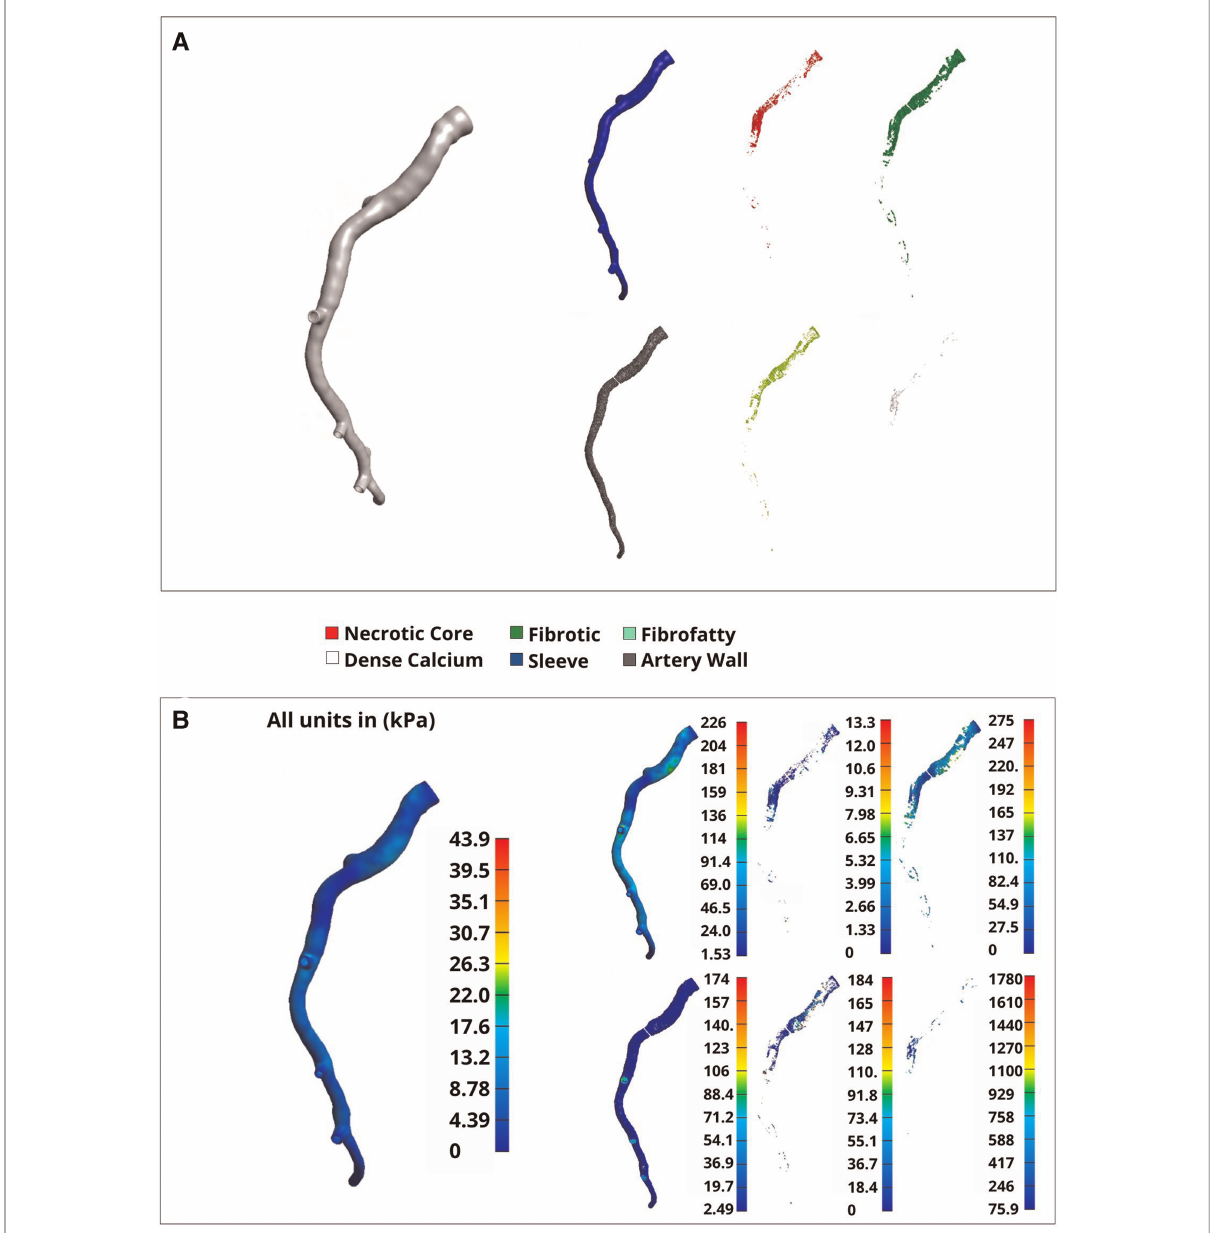
FIGURE 8 Volumetric elements and Von mises stress by material type. A full representative artery was reconstructed at a 0.2 mm resolution with tet4 elements. ( A ) Separated materials that were assigned using the plaque constituent pixel coordinates extracted from VH-IVUS images in “ VH-IVUS image processing and centerline orientation ” . ( B ) Nodal-smoothened effective stress across the entire artery (left) and elemental Von-Mises stress (right) corresponding to the material types noted in ( A